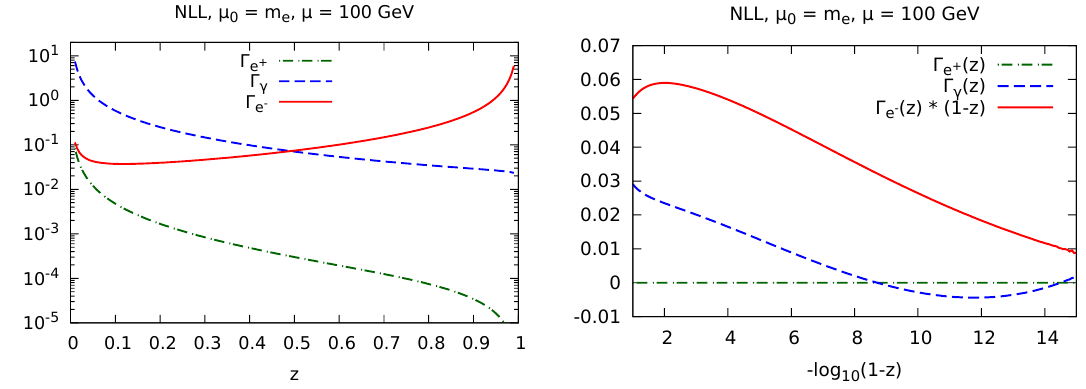
Figure 5 . Electron (solid red), photon (dashed blue), and positron PDFs (dot-dashed green) PDFs at (cid:22) = 100 GeV. The electron PDF is multiplied by a factor (1 (cid:0) z ) in the plot on the right